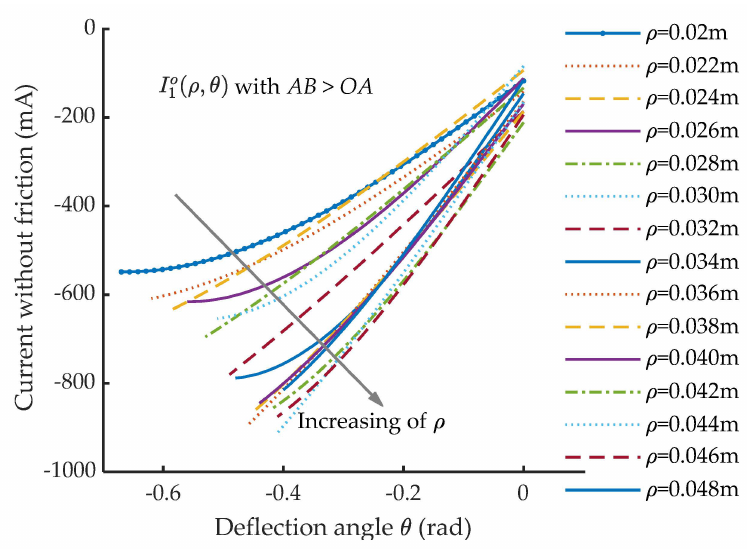
Figure 17. Frictionless current estimation for cam C 1 in configuration I.